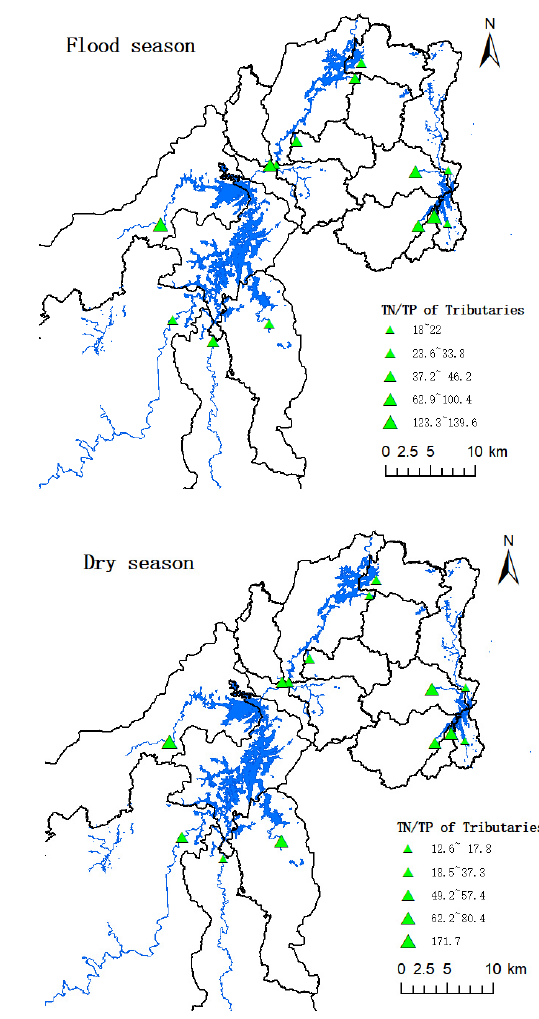
Figure 6. Nitrogen-to-phosphorus ratios at different monitoring points during different seasons in the reservoir area ( left ) and tributaries ( right ).